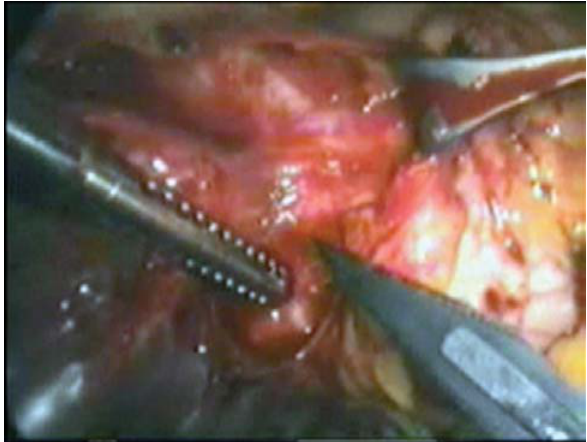
Fig. 1 - Local da atriotomia, com exposição da veia pulmonar superior direita, abaixo do nervo frênico